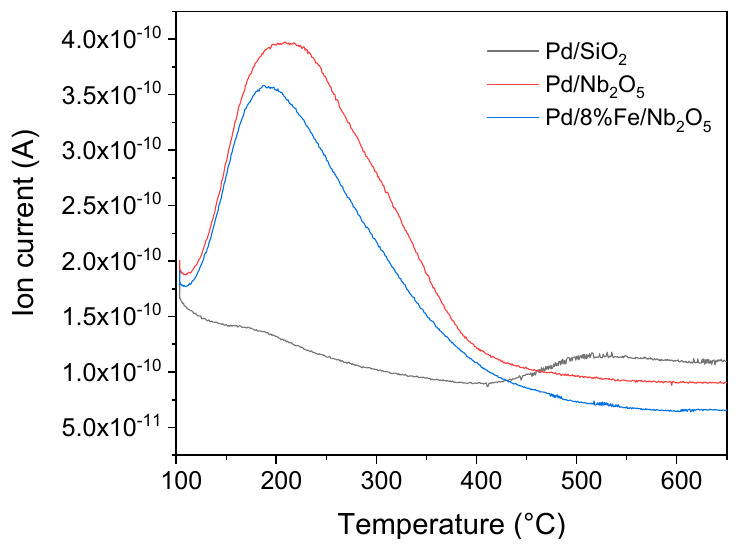
Figure 12. NH 3 -TPD—Ammonia temperature programmed desorption of tested catalysts.